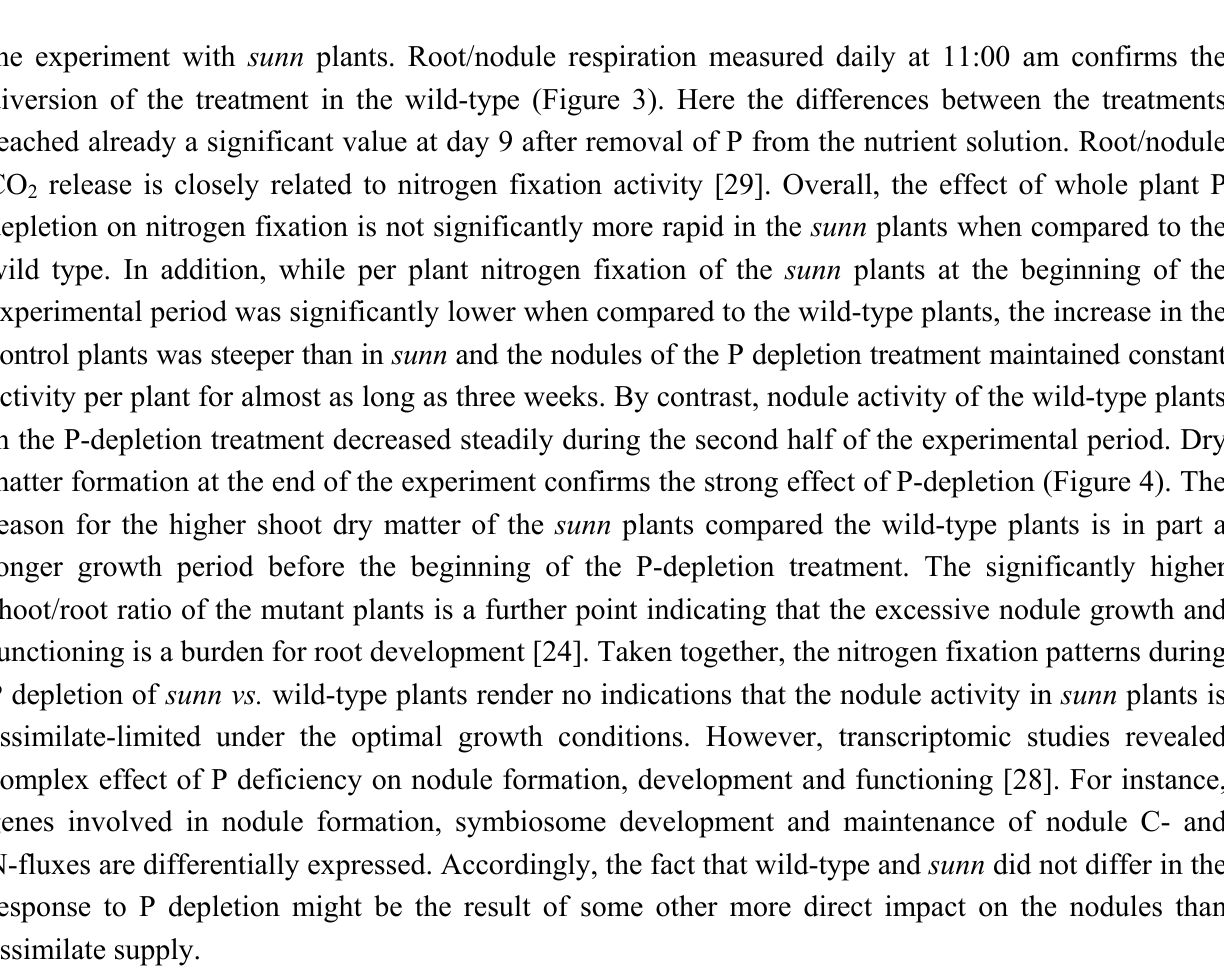
Figure 1. Apparent nitrogenase activity (ANA) of M . truncatula wild-type plants grown